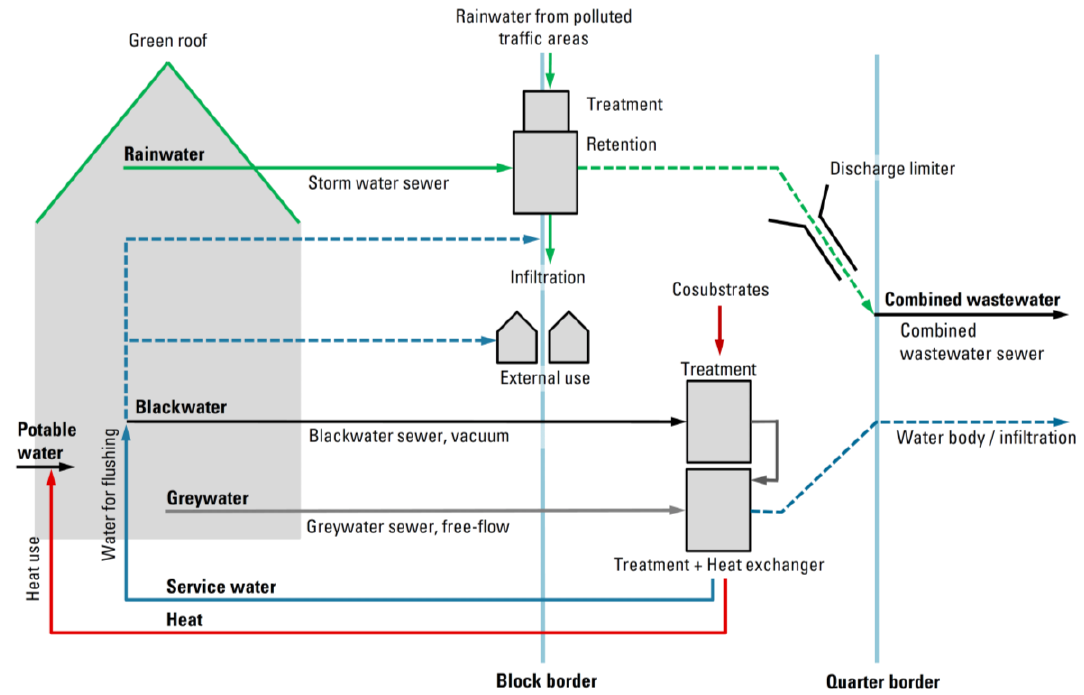
Figure 3. Scheme of the Hamburg Water Cycle (with heat recovery) technical option at the quarter level (based on [31]).